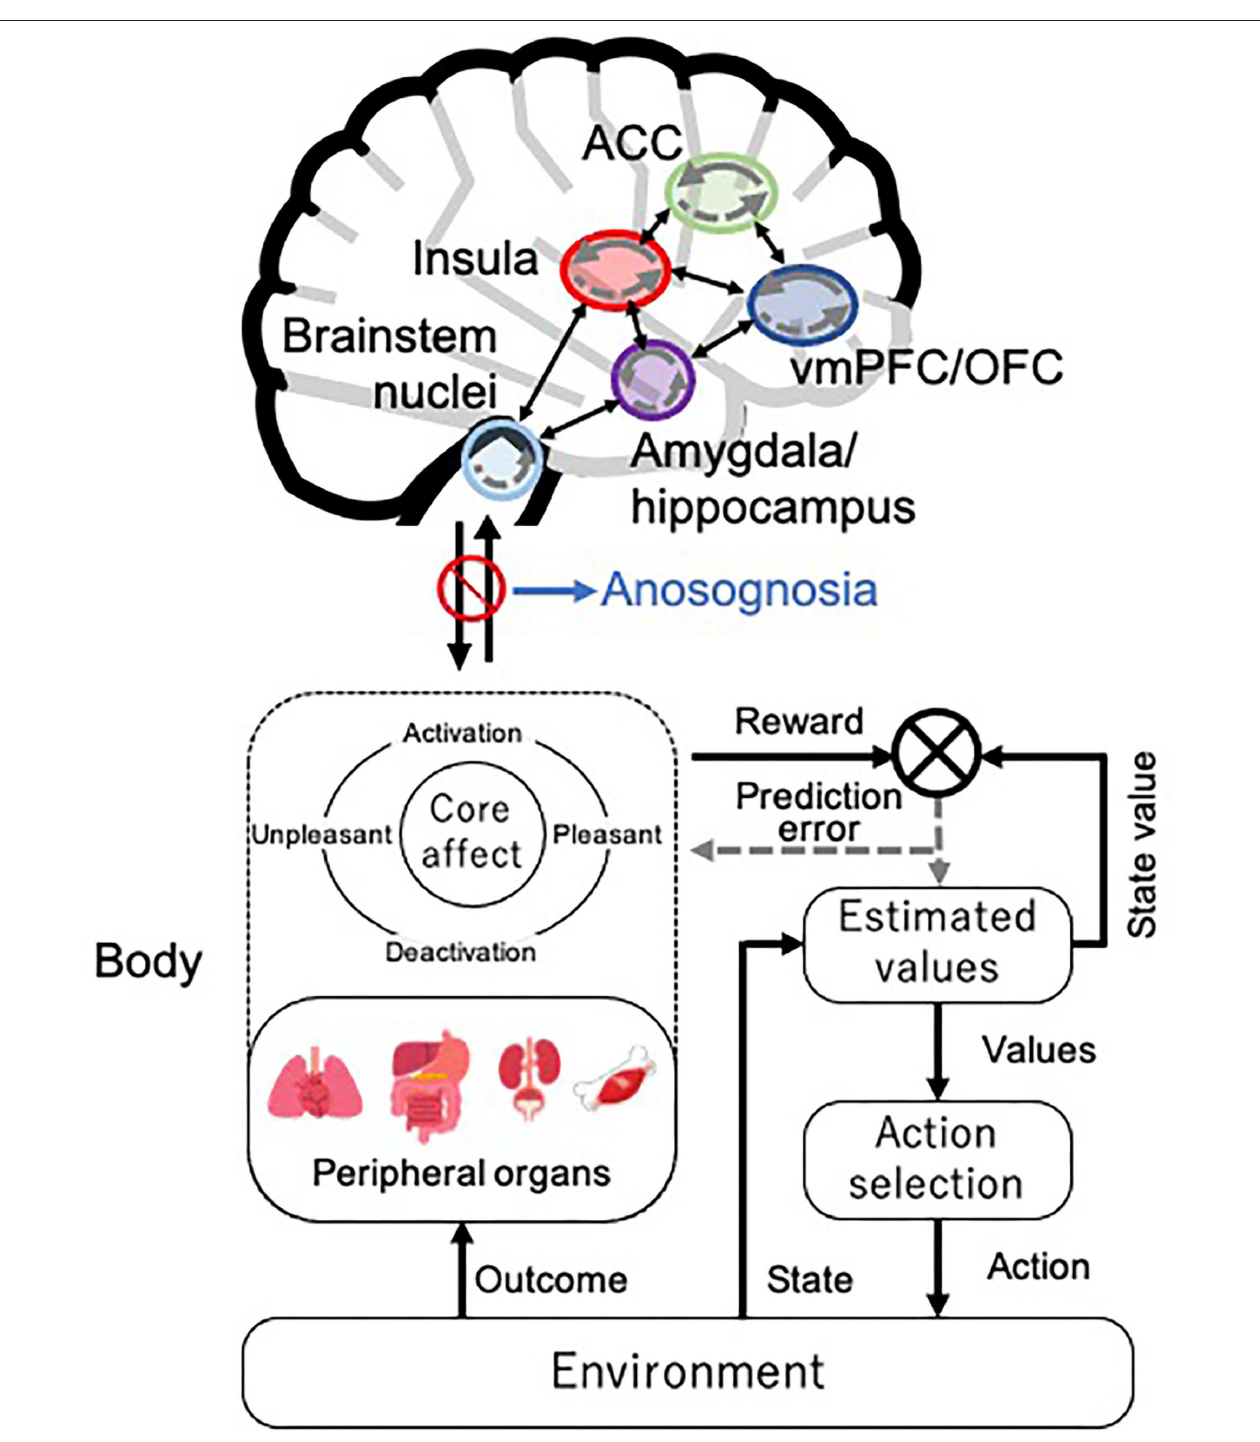
FIGURE 2 | Decision-making model based on interoceptive reinforcement learning. We present the conceptual decision-making model of reinforcement learning in interoceptive prediction. The solid arrows represent the prediction signal, and the dotted arrows represent the prediction error signal within each brain region. ACC, anterior cingulate cortex; vmPFC, ventromedial prefrontal cortex; OFC, orbitofrontal cortex. The brain illustration was used and modified from the following site: Jmarchn, CC BY-SA 3.0, Human brain icon, August 7, 2020, https://commons.wikimedia.org/wiki/File:Human_brain_icon.svg.